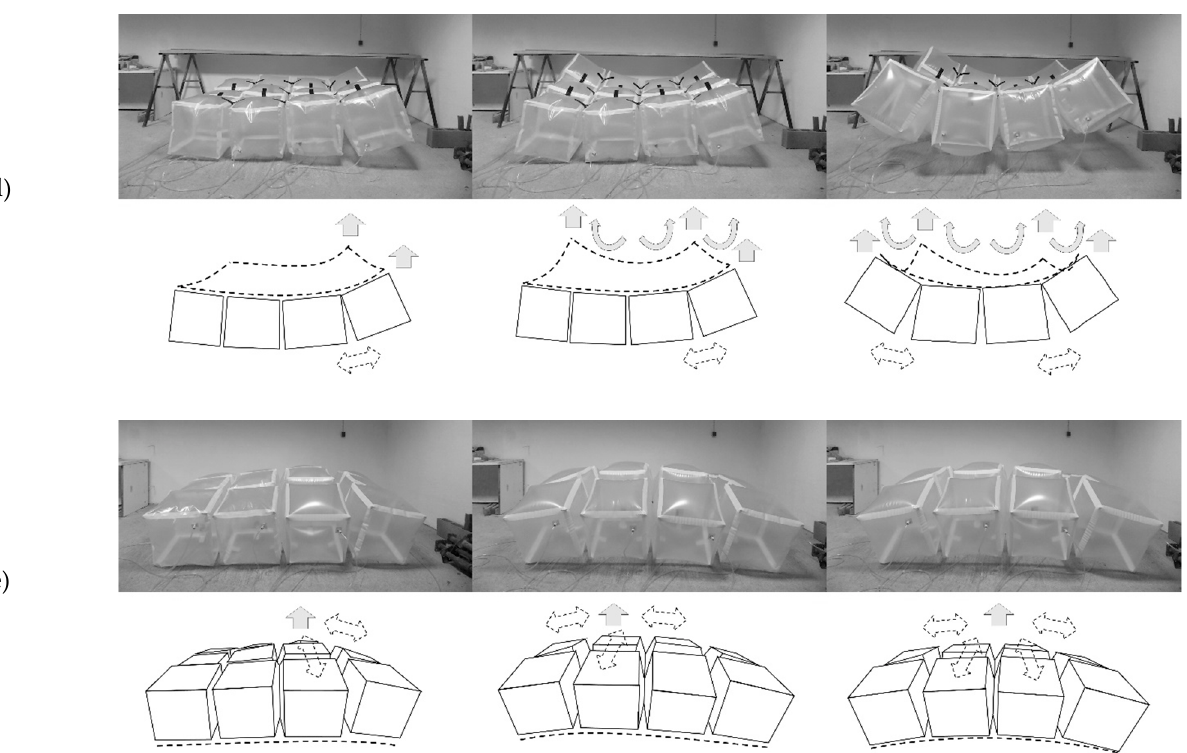
Figure 6. Basic body plan type C1: ( a ) Linear form with flexible side facing down; ( b ) Linear form with flexible side facing up; ( c ) Cantilever structure; ( d ) Planar form with flexible side facing up; ( e ) Planar form with flexible side facing down.